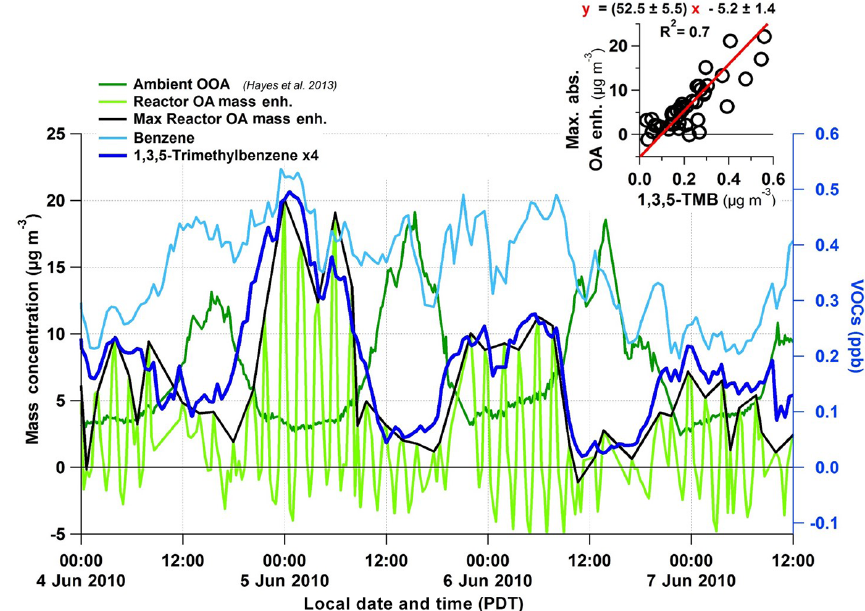
Figure 6. Times series of benzene, 1,3,5-trimethylbenzene (TMB), ambient total oxygenated organic aerosol (OOA), reactor organic mass enhancement, and maximum reactor organic mass enhancement. Inset is a scatter plot of maximum reactor OA mass enhancement (for each OH exp cycle) vs. ambient 1,3,5-TMB, with a linear ODR regression